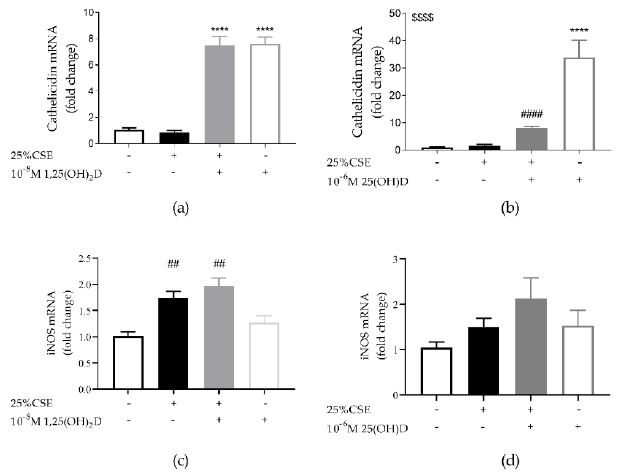
Figure 2. Effect of CSE and vitD exposure on mRNA expression of the antimicrobial peptide cathelicidin and inducible nitric oxide synthase (iNOS) in 16HBE cells. (a) Cathelicidin mRNA expression was upregulated by 1,25(OH) 2 D independently from 25% CSE. (b) 25(OH)D increased cathelicidin expression, but its expression was significantly reduced by CSE-exposure. (c) CSE significantly increased iNOS mRNA expression. There was a trend towards a 1,25(OH) 2 D effect as determined by a two-way ANOVA p = 0.06. (d) CSE and 25(OH)D had no significant effect on iNOS mRNA expression but there was a trend towards a CSE and 25(OH)D effect as determined by a two-way ANOVA ( p = 0.08 and p = 0.09). **** p < 0.0001 effect of vitD, ## p < 0.01, #### p < 0.0001 effects of smoking. $$$$ interaction e ff ect between 25(OH)D and CSE p < 0.01. Data pertain to the result of two independent experiments with three replicates